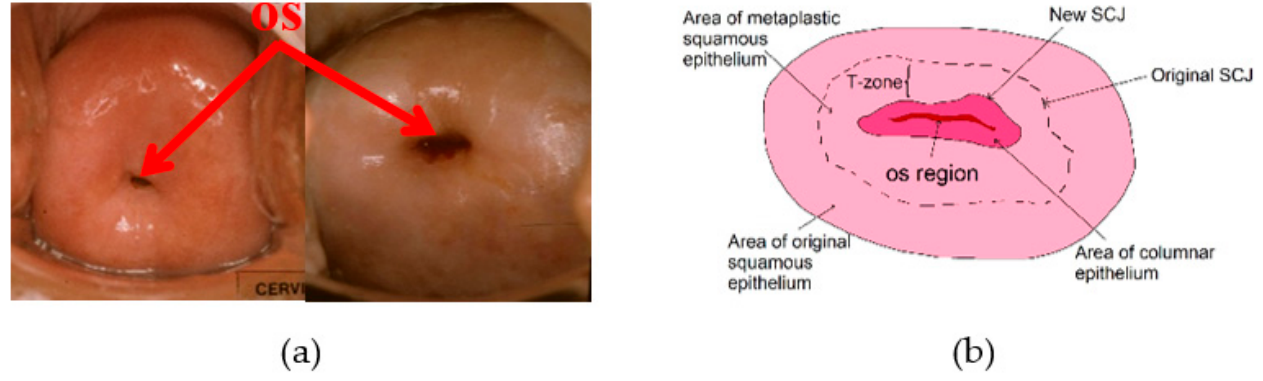
Figure 1. Examples of digitized cervix images and anatomical illustration of a cervix. ( a ) An example of os (the opening into the uterus) having different shapes. ( b ) An illustration of cervix anatomy and illustration of T-zone. The cervix squamous and columnar cell regions are separated by the squamocolumnar junction (SCJ). As a woman ages the SCJ migrates from its original location toward the os.